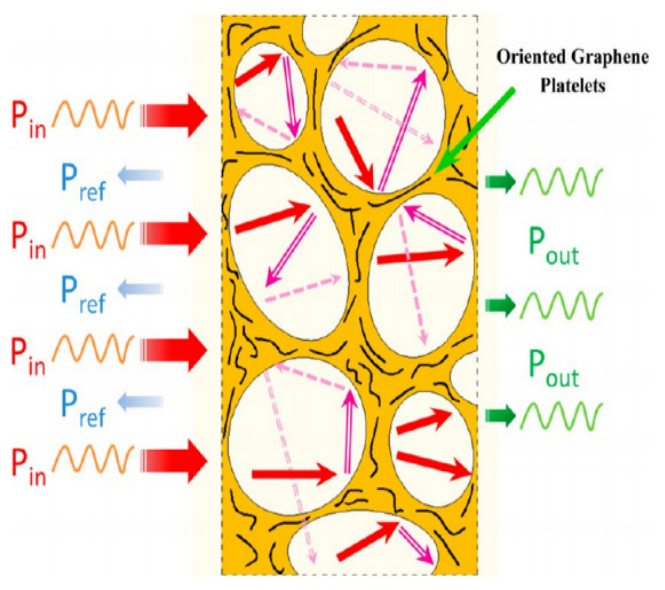
Figure 3. Schematic representation of microwave propagation and scattering across PEI/graphene nanocomposite foam. Reproduced with permission from [95]. Copyright 2013, American Chemical